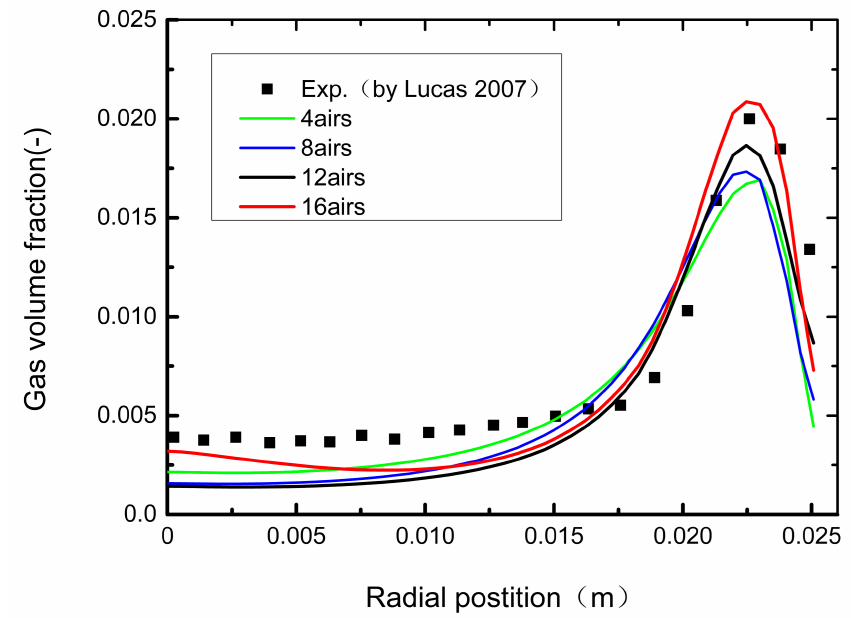
Figure 10. Distributions of gas volume fraction along the pipe radius in different